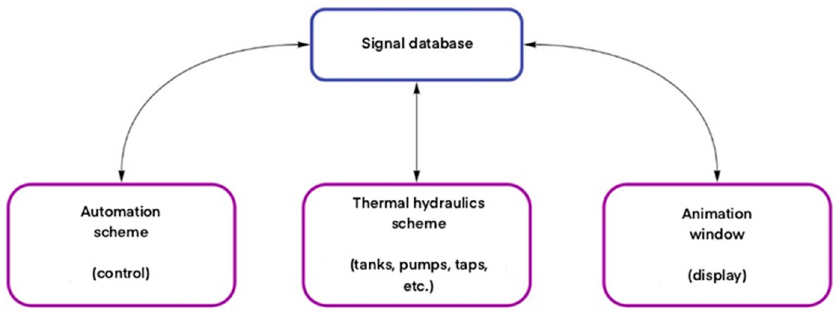
Figure 1. Schematic diagram of a simulation model for a fuel system of a helicopter.